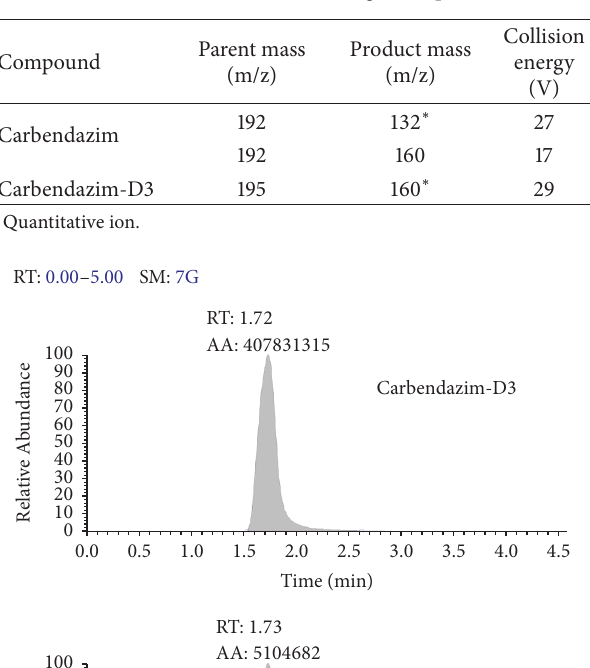
Table 2: SRM conditions for target compounds.